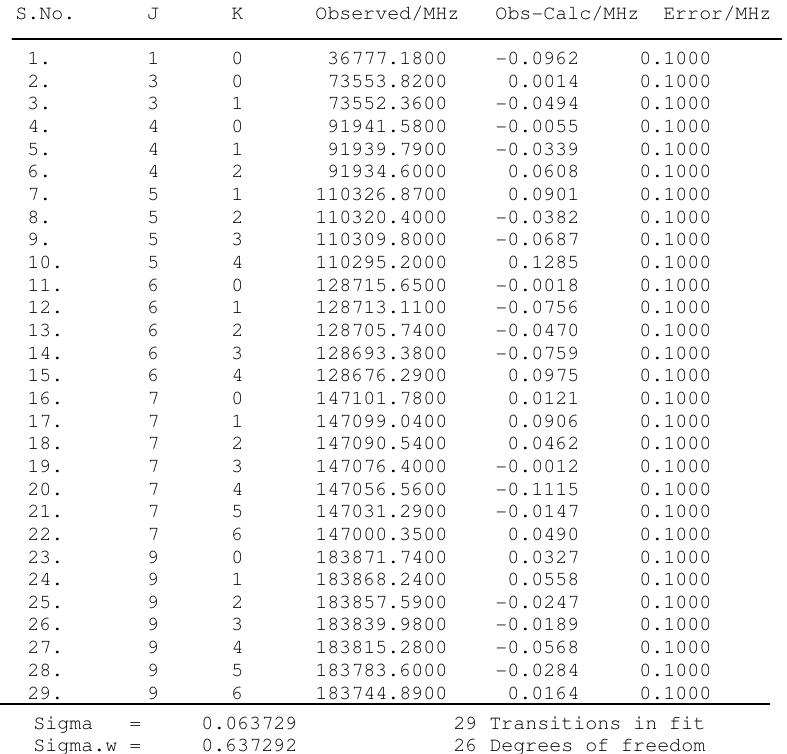
Table 6 . Results of refinement of observed frequencies for CH